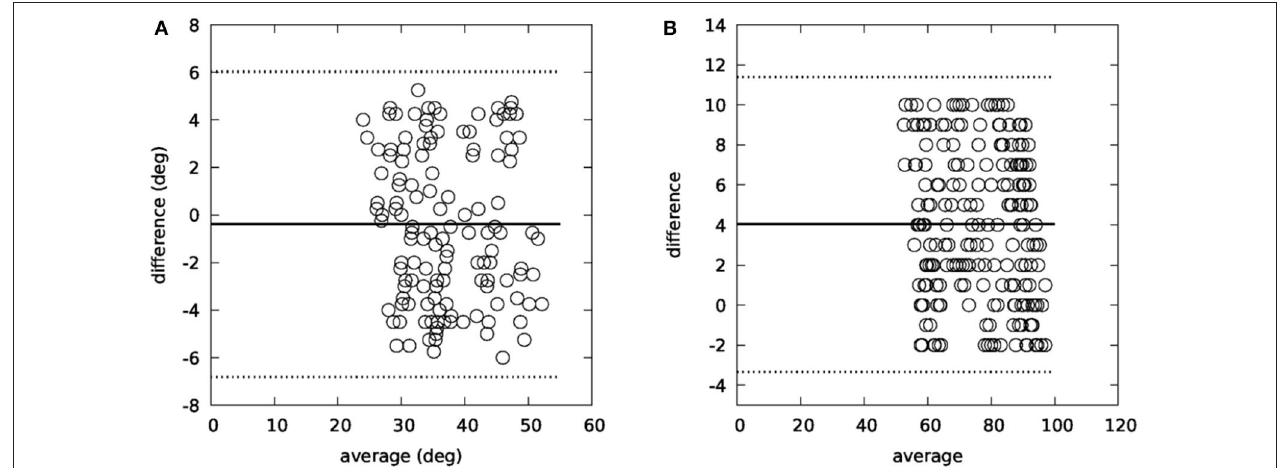
FIGURE 9 | Bland–Altman plots for yaw (A) and pitch (B)